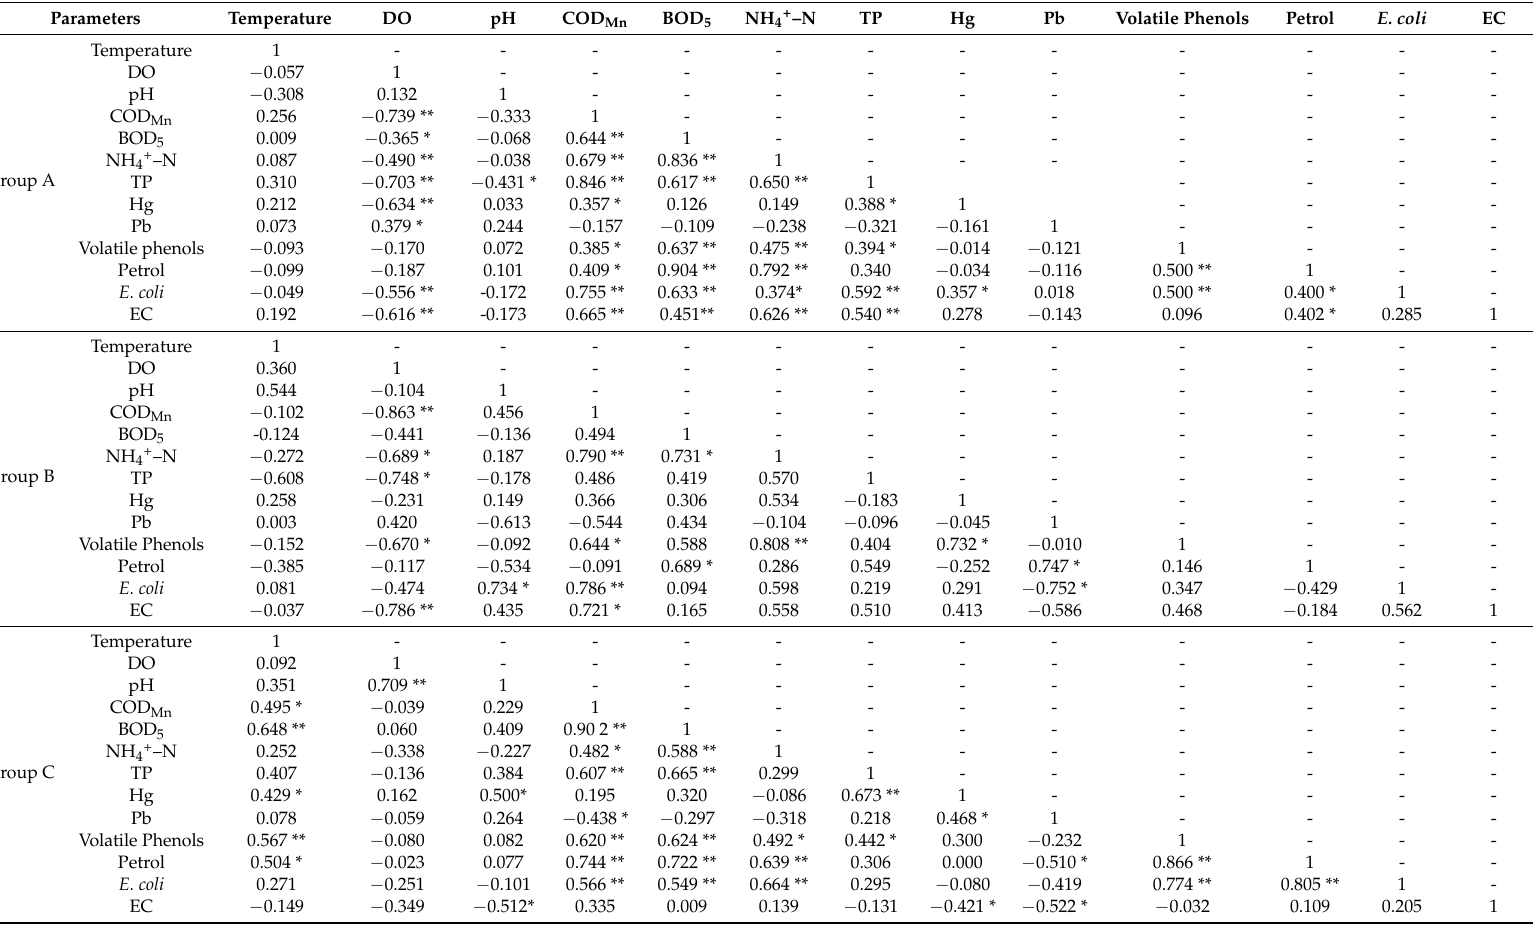
Table 2. Pearson correlation matrix of the 13 analyzed physical-chemical water quality